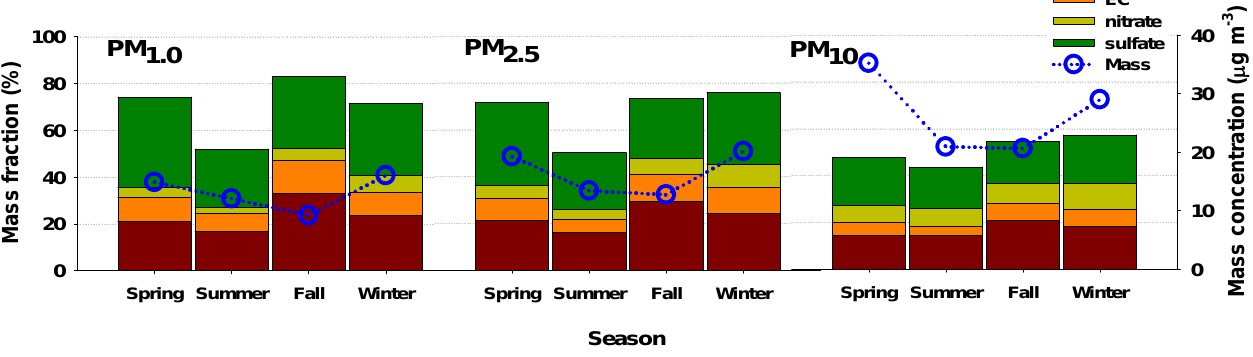
Fig. 5. Seasonal variations of mass concentrations (blue circle) and fractions of OC, EC, nitrate, and sulfate against mass in PM 1 . 0 , PM 2 . 5 , and PM 10 . Spring, summer, fall, and winter include March to May, June to early September, October to November, and December to February,